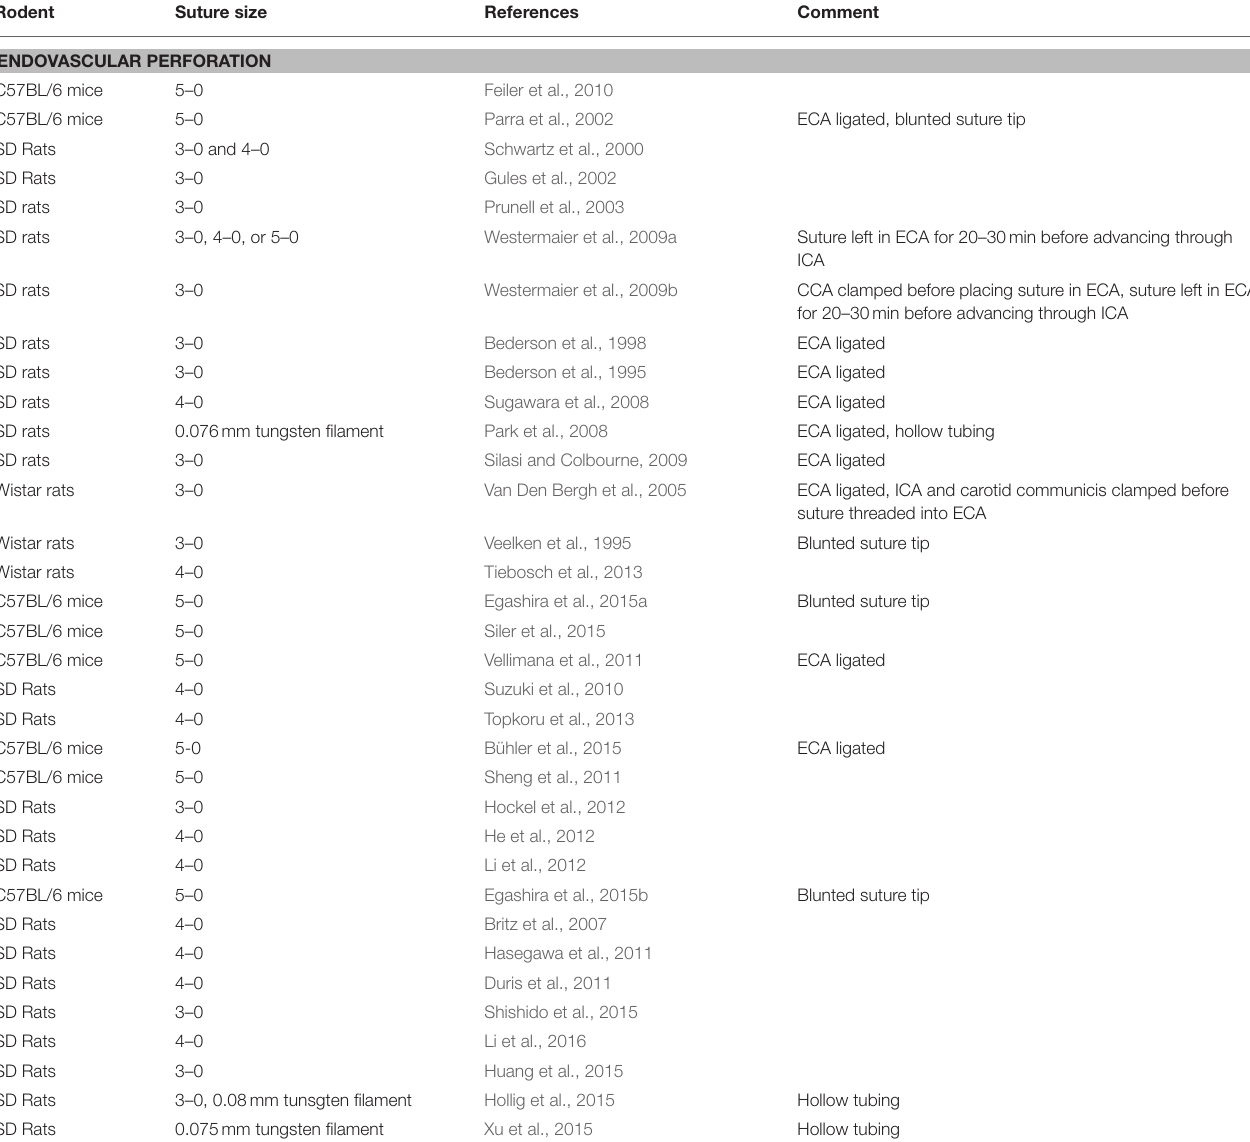
TABLE 2 | Summary of endovascular perforation models in published studies that used various strains of mice or rats.